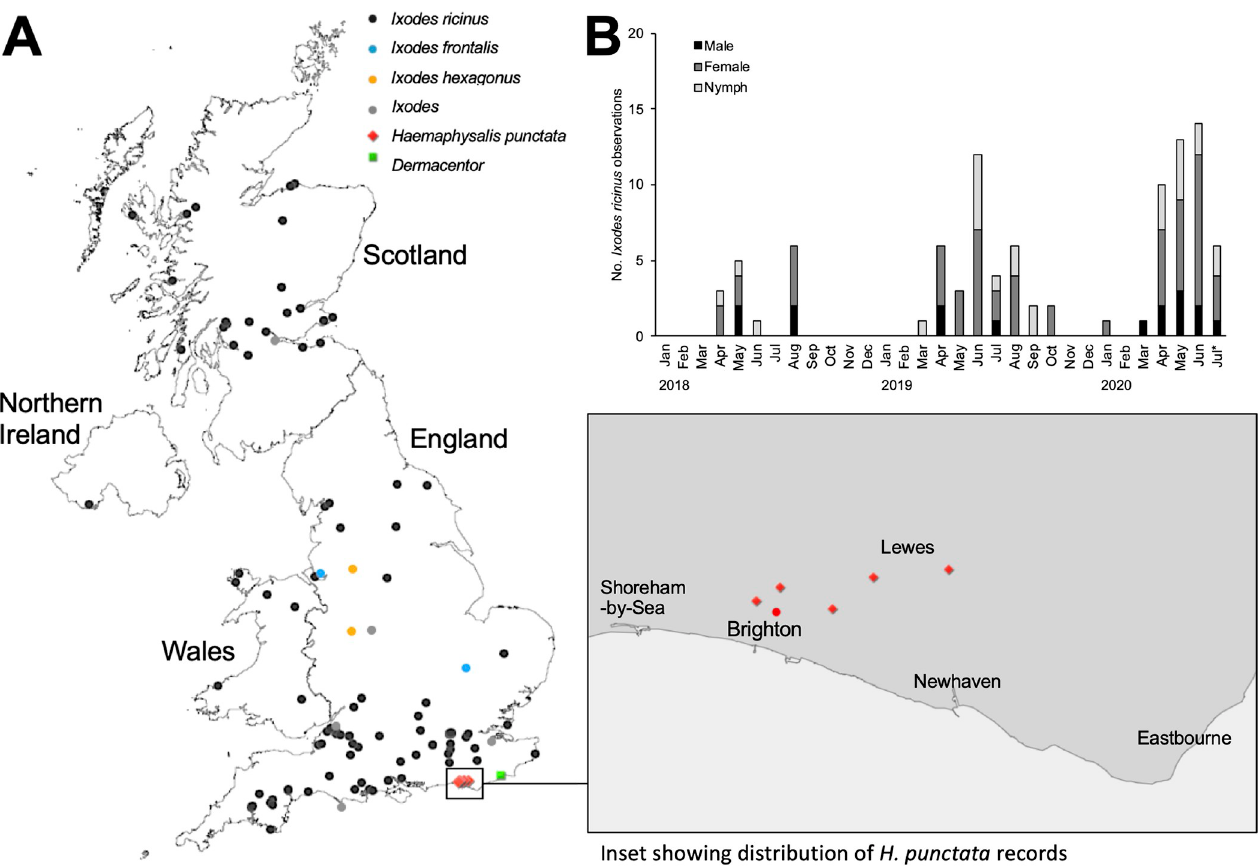
Fig 2. Summary of iNaturalist records of ticks in the United Kingdom. (A) Distribution of tick records by genus/species. Inset shows detection of a known localized population of Haemaphysalis punctata in southeast England (see Medlock et al., 2018); red circle shows potential H . punctata record. (B) Seasonality of Ixodes ricinus (separated by life stage) recorded in the UK by iNaturalist users 2018–2020 ( � complete to 20 July 2020).